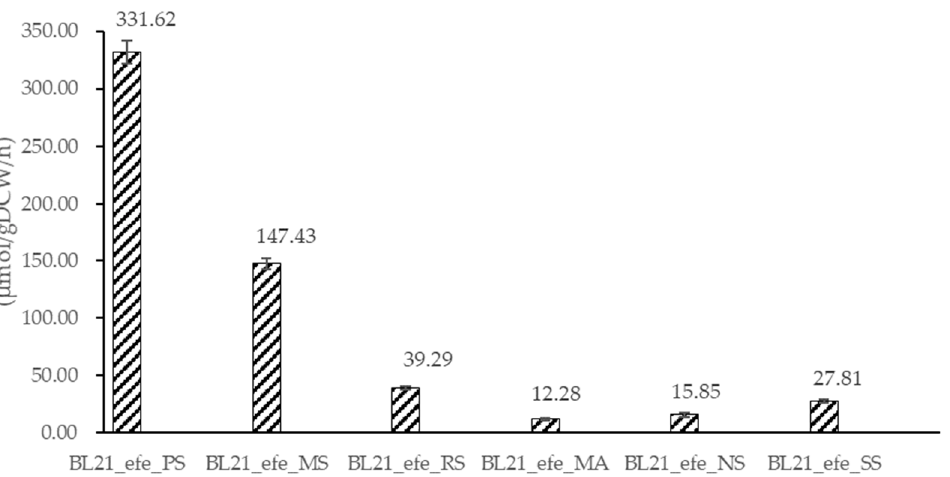
Figure 9. Ethylene production of BL21_ efe + engineering strains in LB with 0.02% arabinose under 20 °C. Activity was calculated by the ethylene production per gram dry cell per hour.